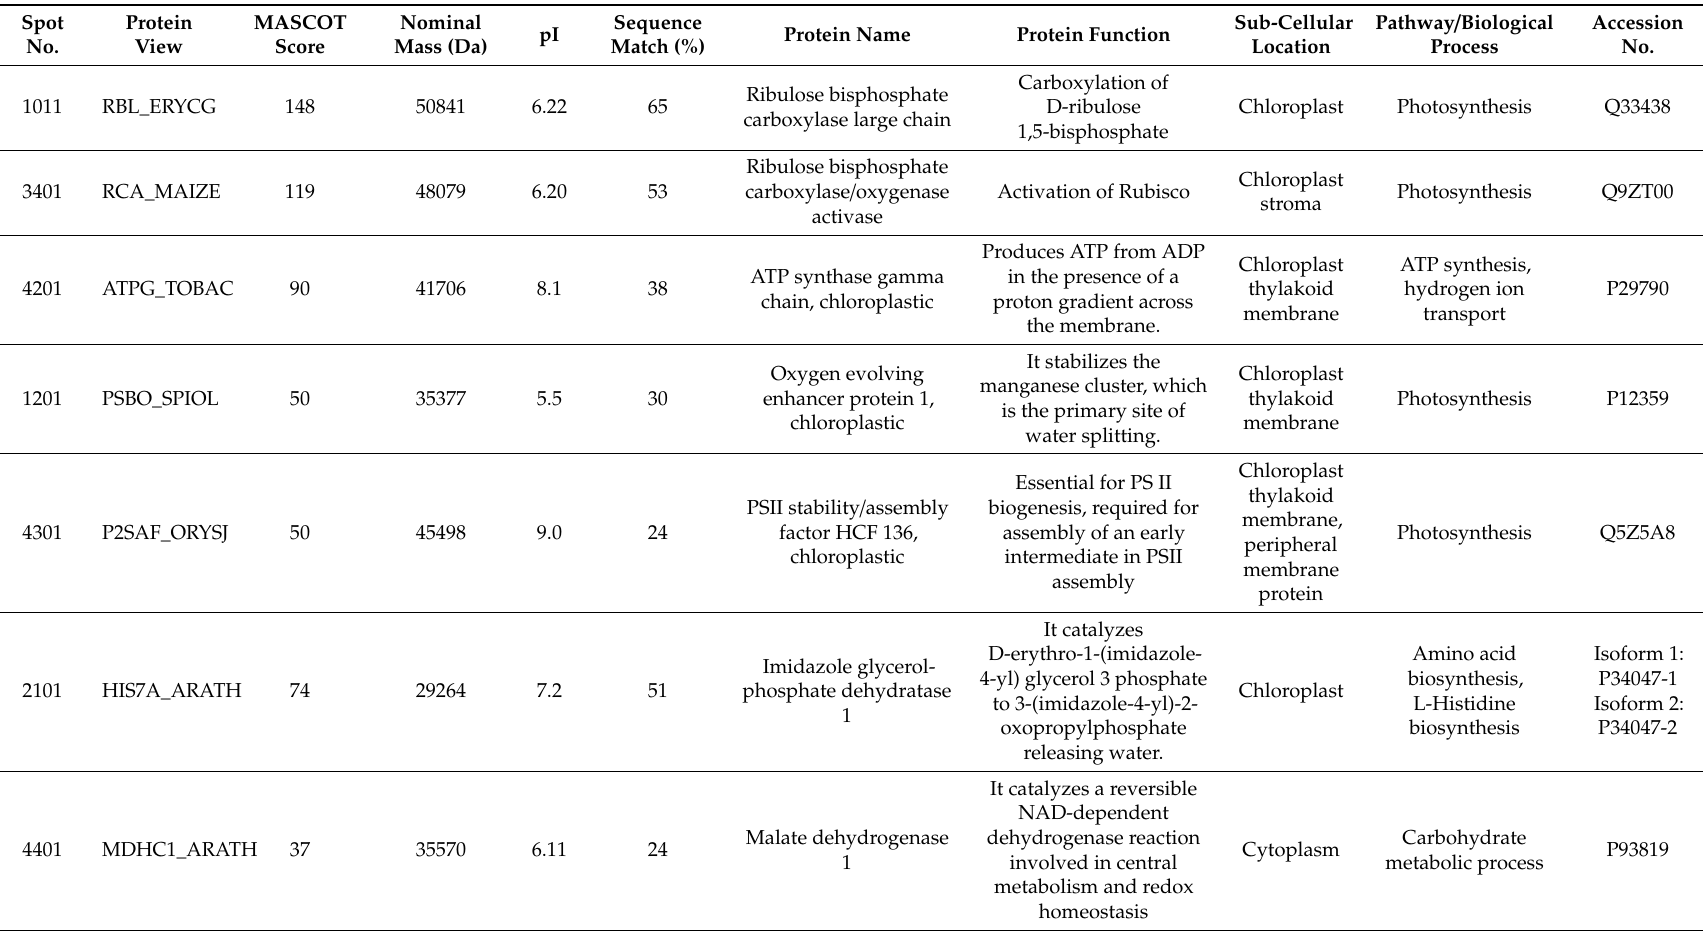
Table 4. Molecular functions, metabolic pathways, and accession numbers of the identified